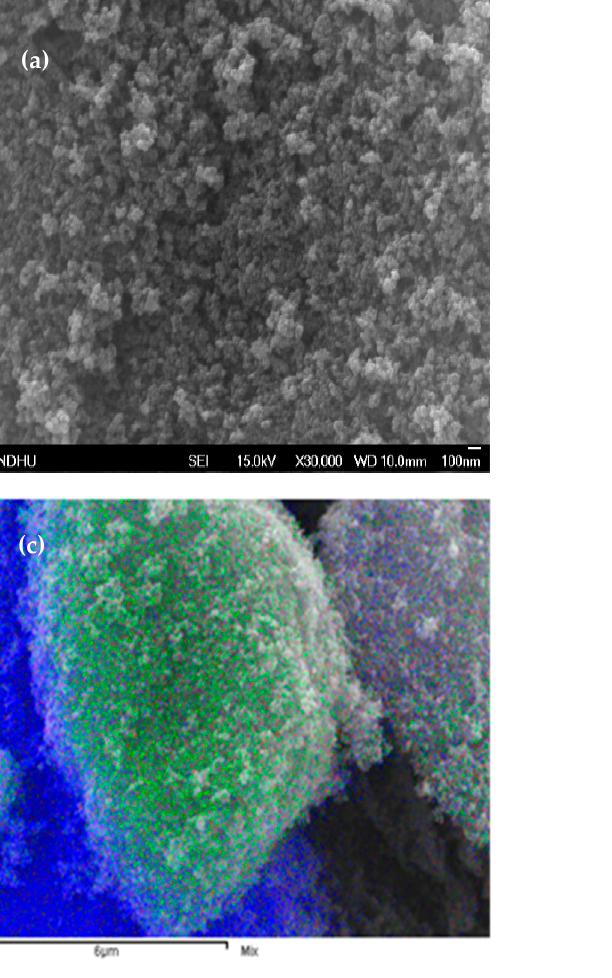
Figure 6. SEM images: ( a ) SEM spectrum, ( b ) EDS of PN-TiO 2 composite, ( c ) overlapping of P, Ti, and C elements, ( d – f ) elemental maps of 3% PN-TiO 2